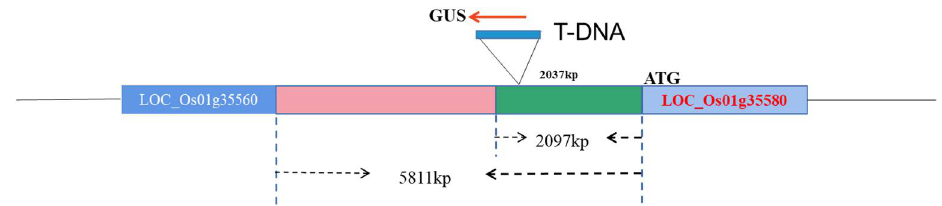
Figure 1. A schematic diagram showing the insertion position of